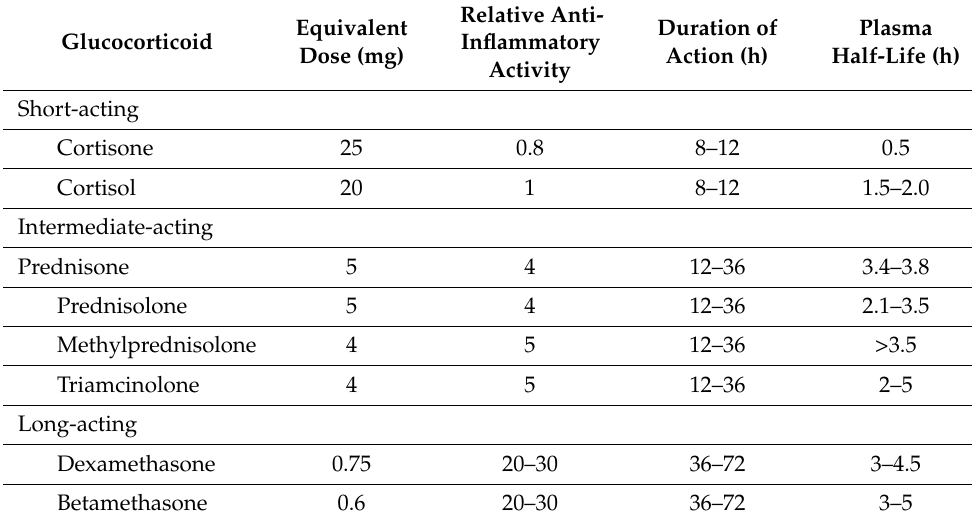
Table 1. Comparison of